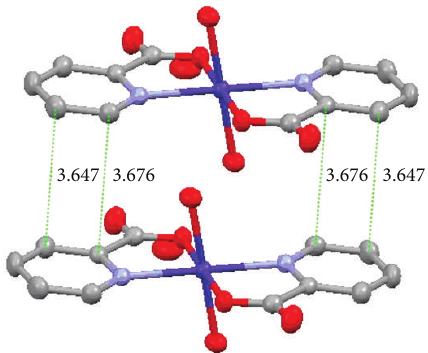
Figure 5: Weak spatial 𝜋 - 𝜋 stacking interactions of the title complex.